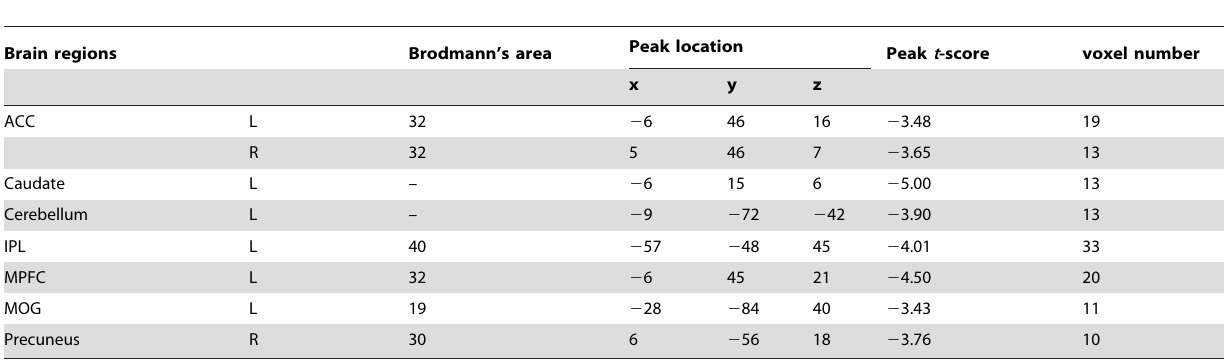
Table 3. Activated brain regions for the LA group in contrast to the SA group in response to heroin-related vs. neutral cues.